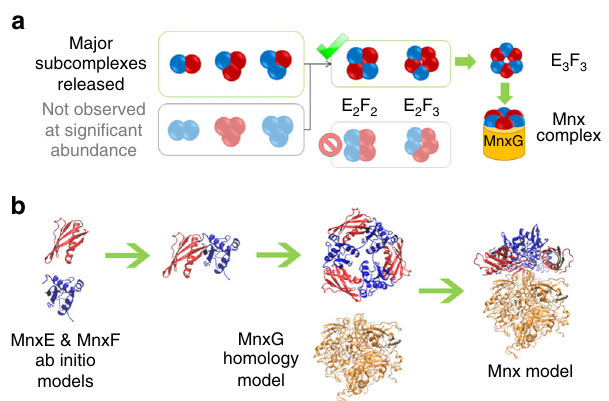
Fig. 4 Building a structural model of Mnx based on the subunit connectivity determined from native MS experiment. a Determination of the topology of Mnx complex based on observed subcomplexes released in SID. The major species observed for the released MnxEF dimers are E 1 F 1 , and for the released trimers are E 1 F 2 (~2/3 of the trimer in the spectrum), and E 2 F 1 (~1/3 of the trimer in the spectrum). The lack of a strong signal for homo- dimers and homo-trimers ruled out some possible con fi gurations for the observed E 2 F 2 and E 2 F 3 subcomplexes, leaving a symmetric hexamer structure being the most reasonable solution. b With the topology proposed based on SID data, computational models of the subunits can be docked to generate possible models of Mnx complex with additional constraints from CCS and surface labeling experiments (Supplementary Methods and Supplementary Fig. 5)